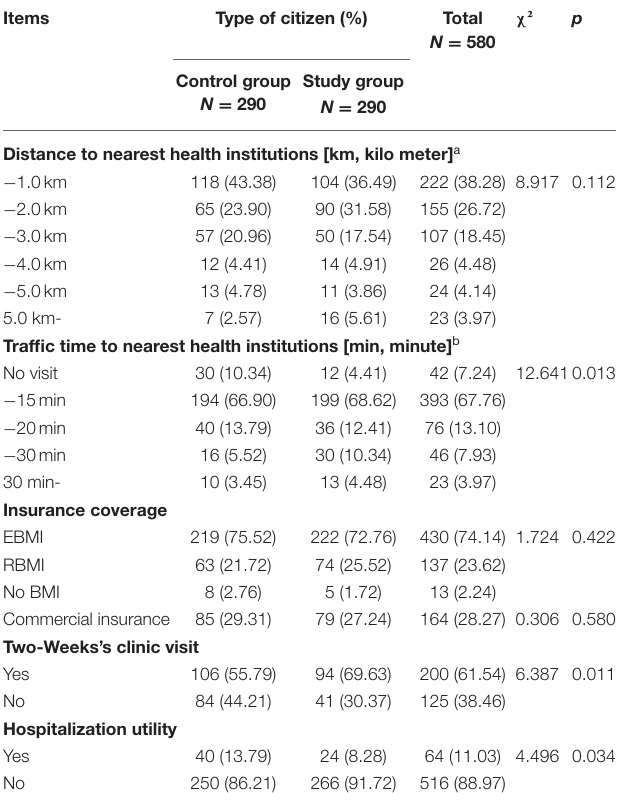
TABLE 3 | Healthcare services utilization indicators of different group.